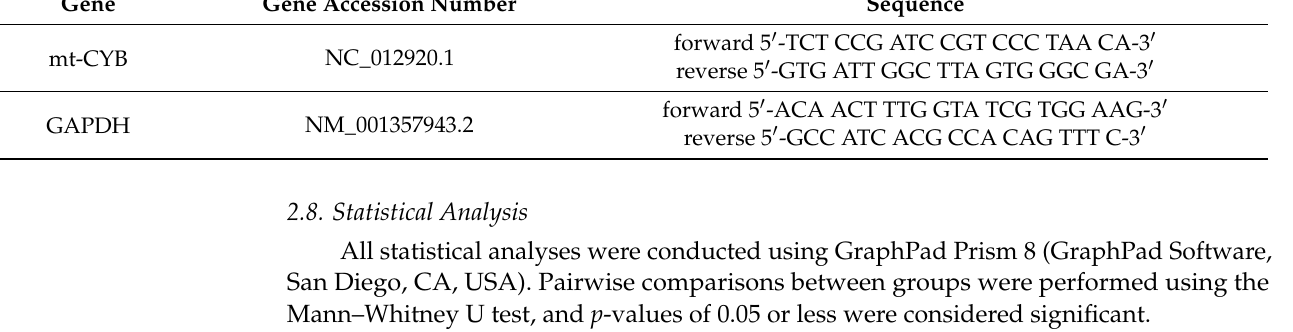
Table 1. Gene targets and primers used for mtDNA measurement. Gene Gene Accession Number